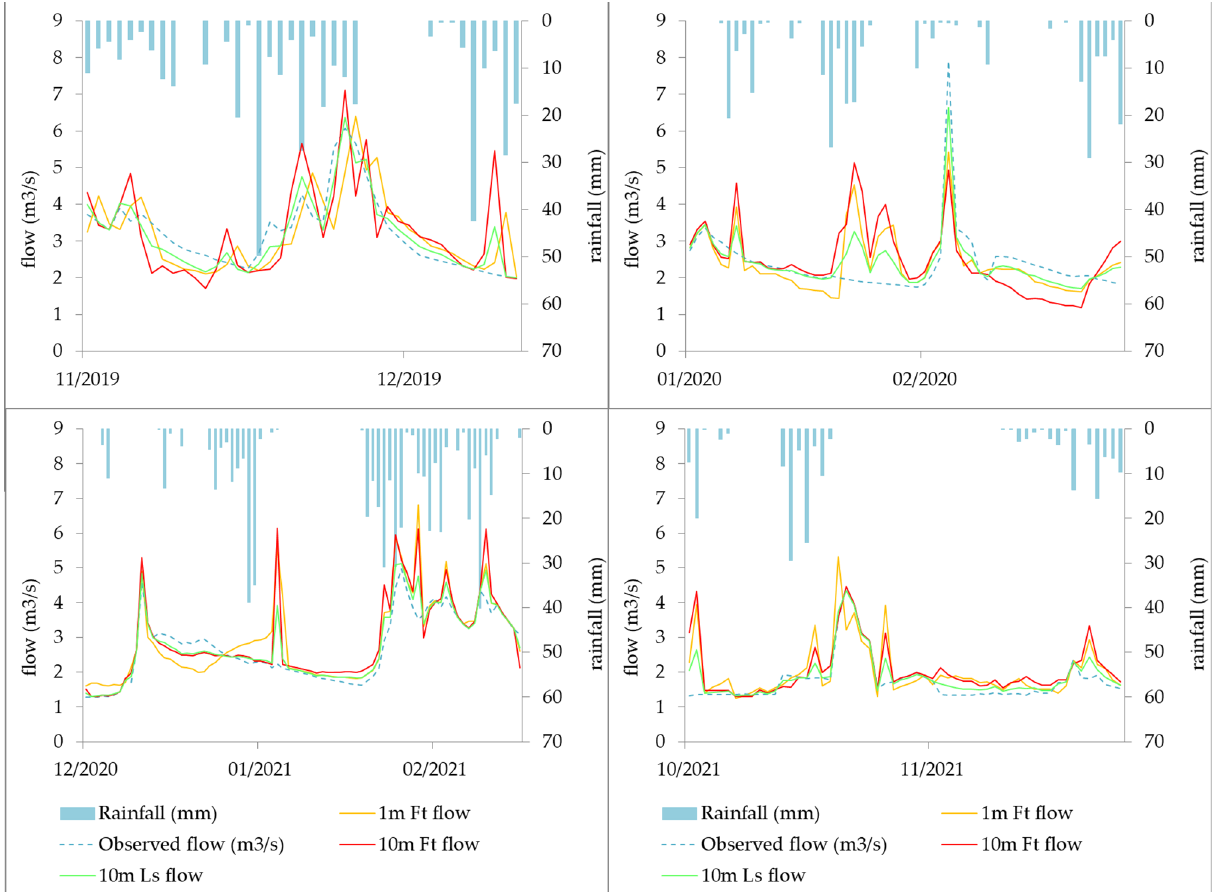
Figure 7. Observed and simulated streamflow for the no terraces scenarios (1 m and 10 m Ft DEMs, and 10 m Ls DEM), from November 2019 to November 2021.